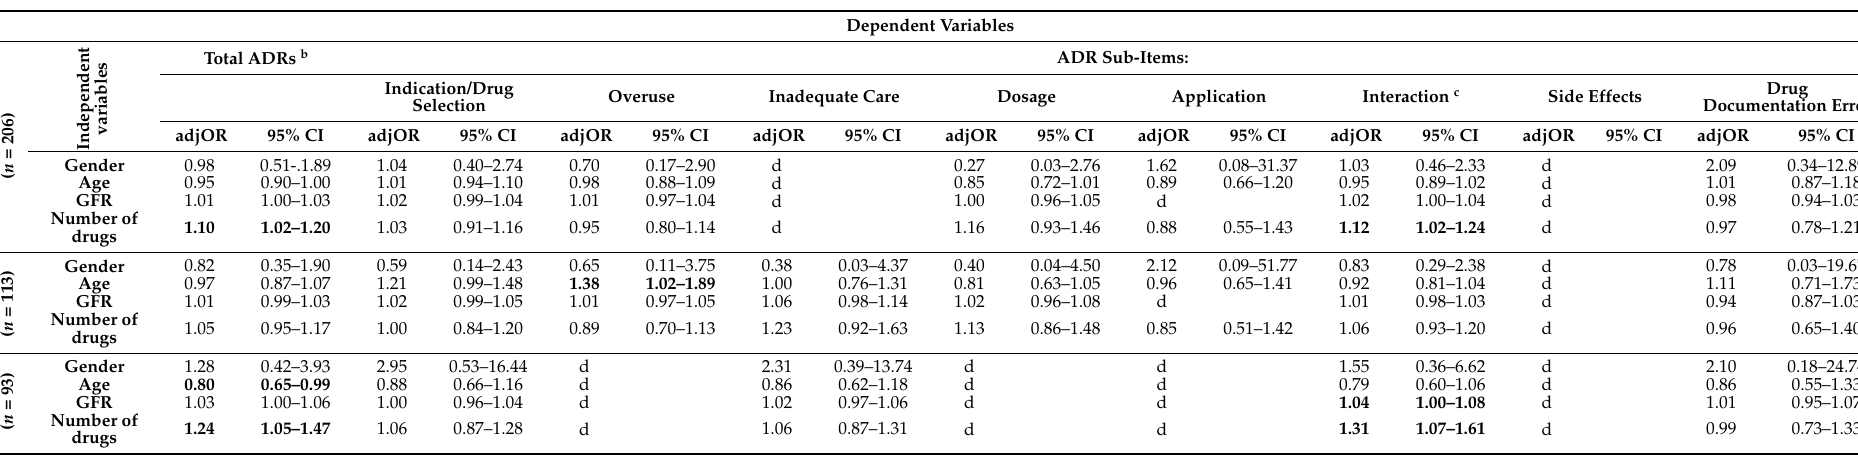
Table 5. Correlations between dependent variables, such as ADRs (adverse drug reactions), and their subcategories and independent variables, such as age, gender, glomerular filtration efficiency (GFR) as well as the number of prescribed drugs in binary logistic regression models a